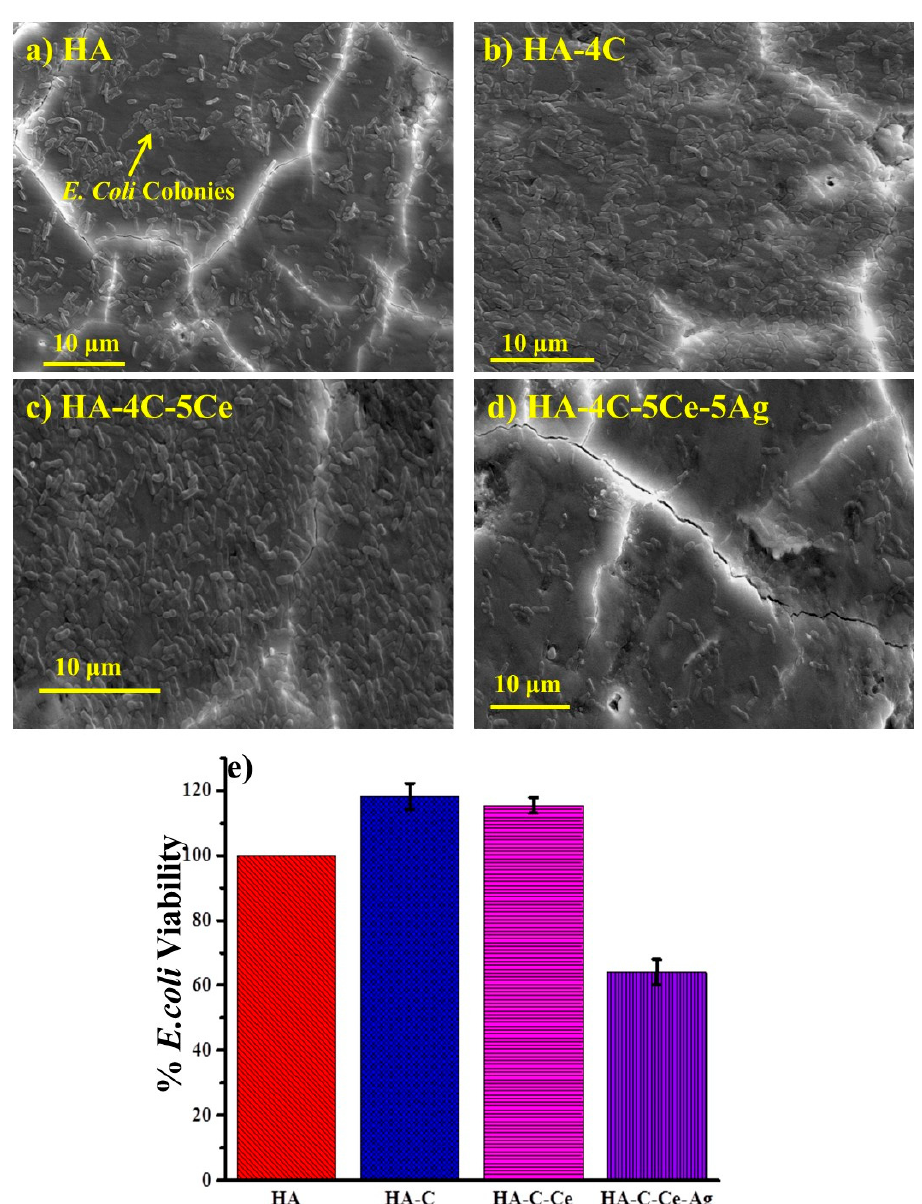
Figure 9. Scanning electron micrographs ( a – d ) and quantitative estimation ( e ) of E. coli on HA-based plasma sprayed coatings.